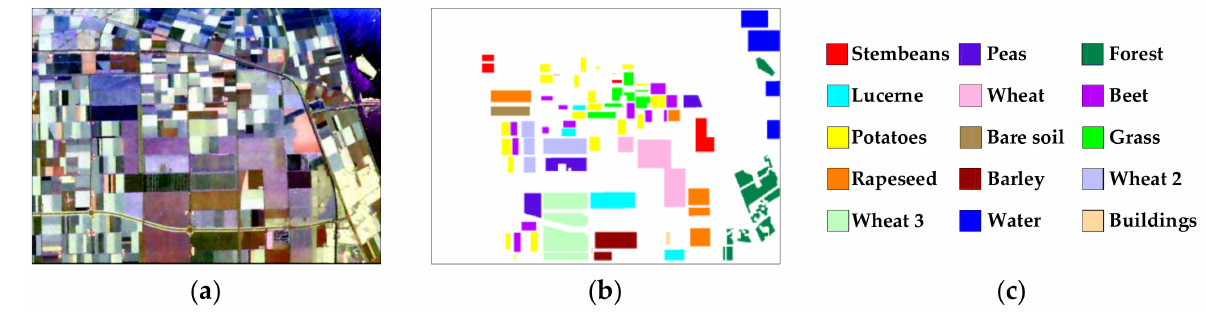
Figure 4. ( a ) Pauli-RGB image of dataset 1, ( b ) ground-truth [17] and ( c ) legend. Dataset 2, acquired by the AIRSAR system in 1991, is an L-band PolSAR image of another region in Flevoland, Netherlands, consisting of 1020 × 1024 pixels. Its Pauli-RGB image, ground-truth map and legend are shown in Figure 5a–c, respectively. It has 14 labeled terrain categories, i.e., potato, fruit, oats, beet, barley, onions, wheat, beans, peas, maize, flax, rapeseed, grass, and lucerne. The total number of labeled pixels is 135,350.